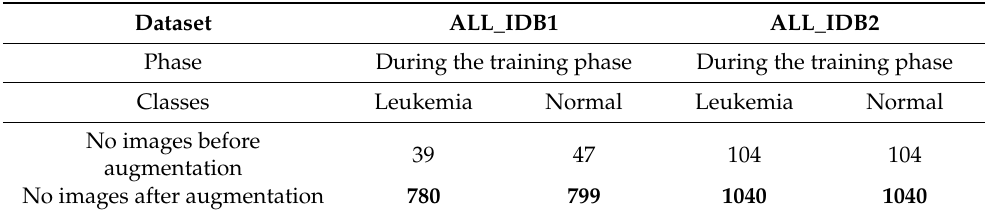
Table 3. Balancing ALL_IDB1 and ALL_IDB2 datasets during the training phase.